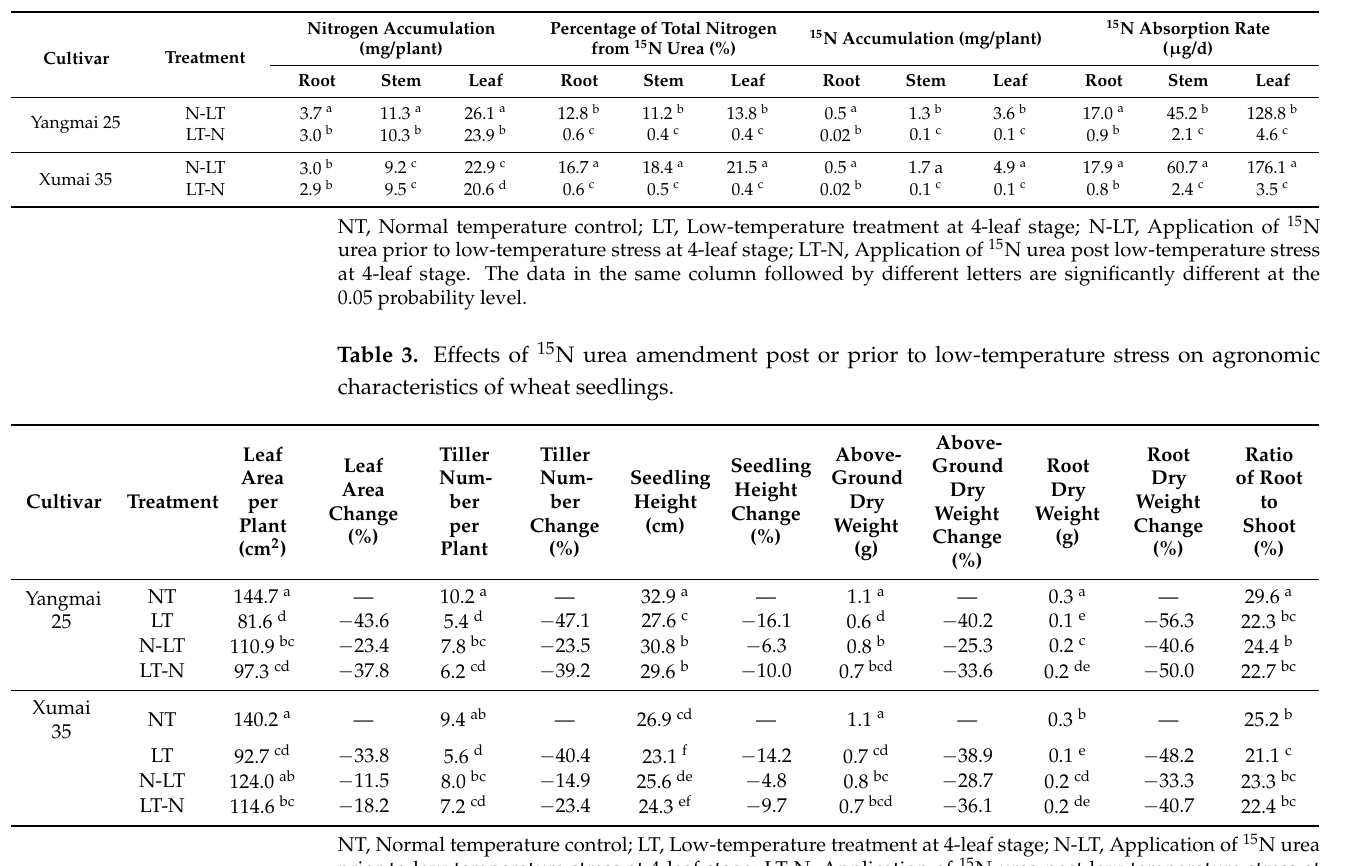
Table 2. Effects of 15 N urea amendment post or prior to low-temperature stress on nitrogen accumu- lation and distribution in wheat seedlings.